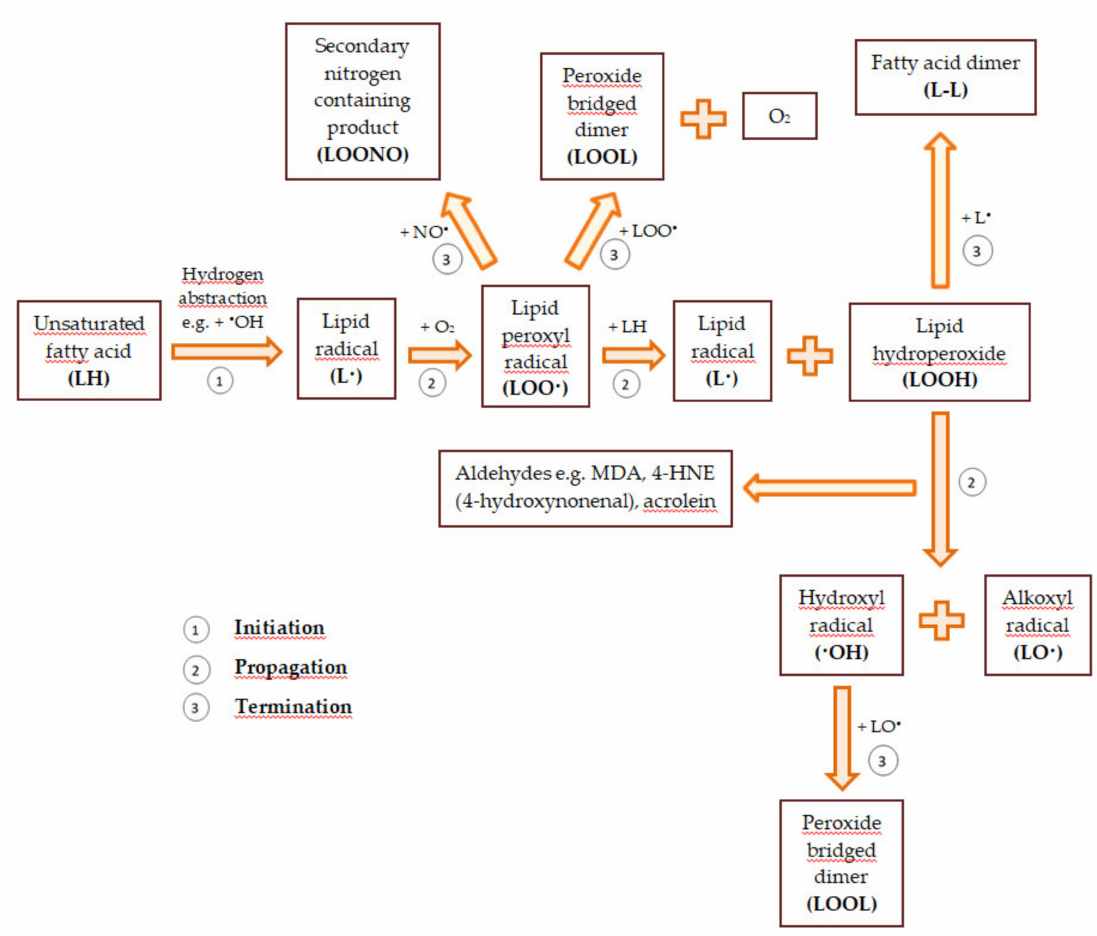
Figure 1. The general scheme of lipid peroxidation based on